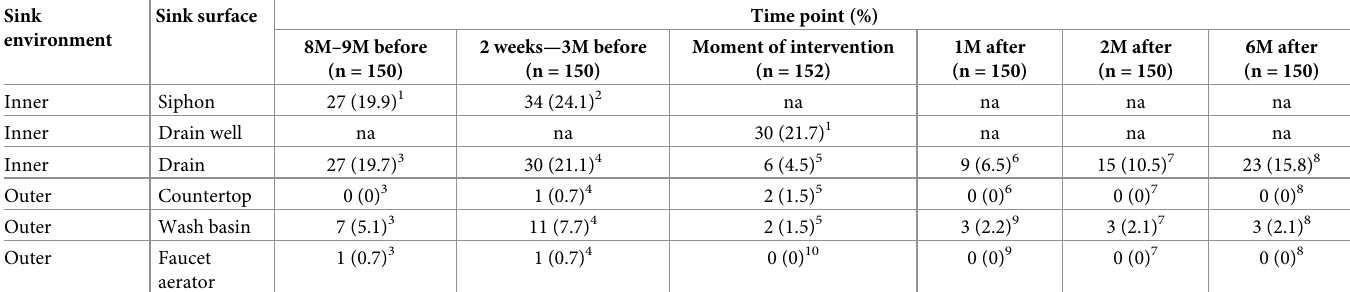
Table 3. Percentages of VIM-PA-positive samples found at every sampling moment before and after the intervention per sink